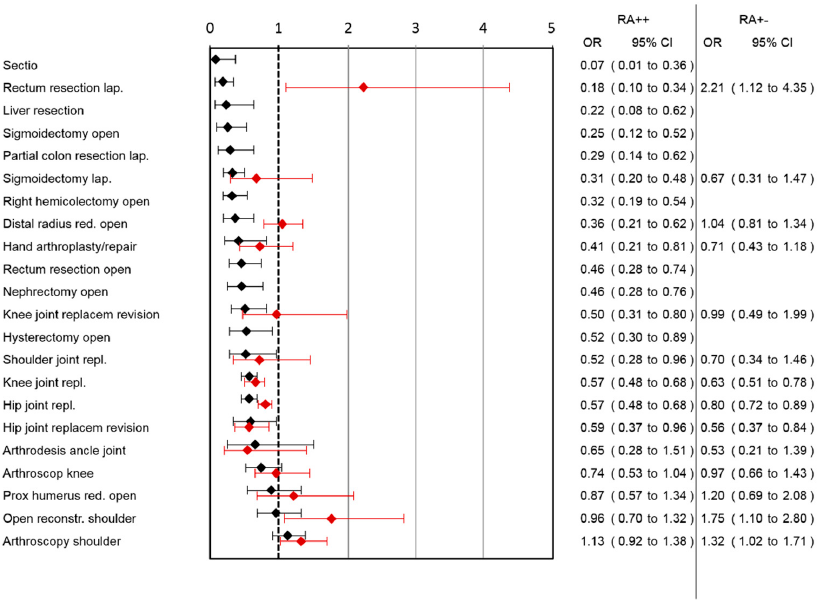
Figure 4. Association of RA with opioid use in different surgical categories. Patients with continuous (RA++; black lines) or single-shot RA (RA+ − ; red lines) are compared to patients without RA (RA −− ). OR and corresponding 95% confidence intervals for both analyses are shown.